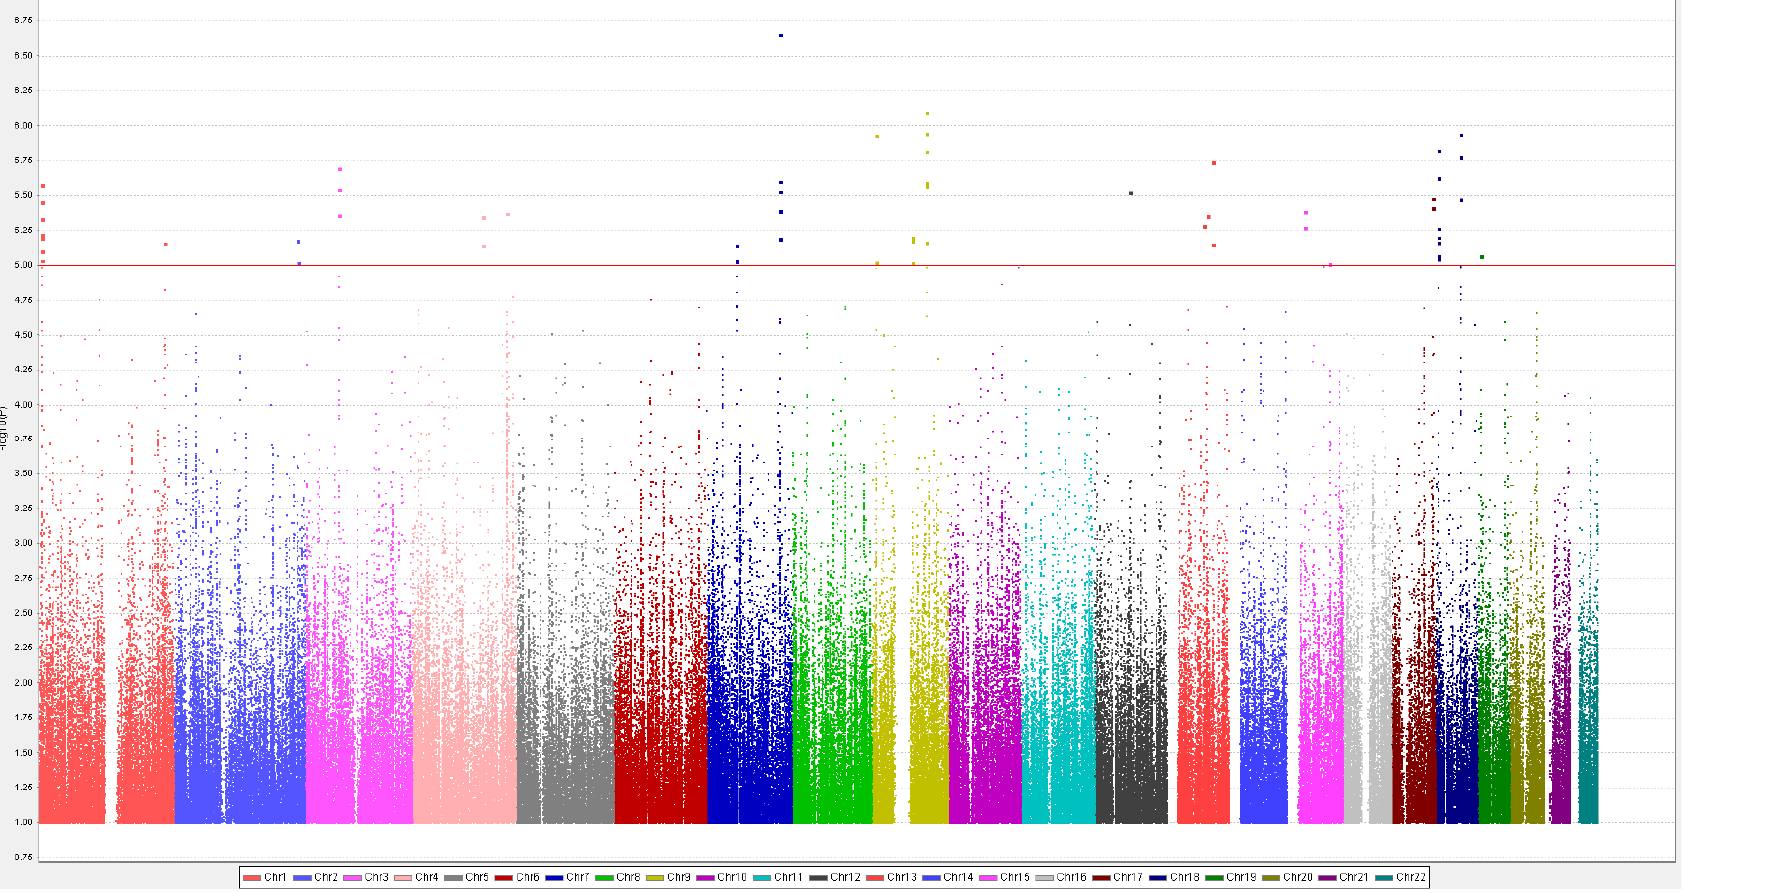
Figure 3. Genome-wide association between single-nucleotide polymorphisms (SNPs) and manic switch after bipolar depressive episodes. Results from the association between individual SNPs and manic switch after depressive episodes treated with antidepressants in 746 patients with bipolar I disorder. The negative log of the P value for the association, as calculated by means of the chi-square test for the dominant model, is plotted against the chromosomal location across the genome. The horizontal line indicates the significance level of 1.0 × 10 − 6 , which was achieved by a few SNPs. The highest SNPs on chromosome 7 are located in the intergenic region between LUZP6 and CHRM2 .